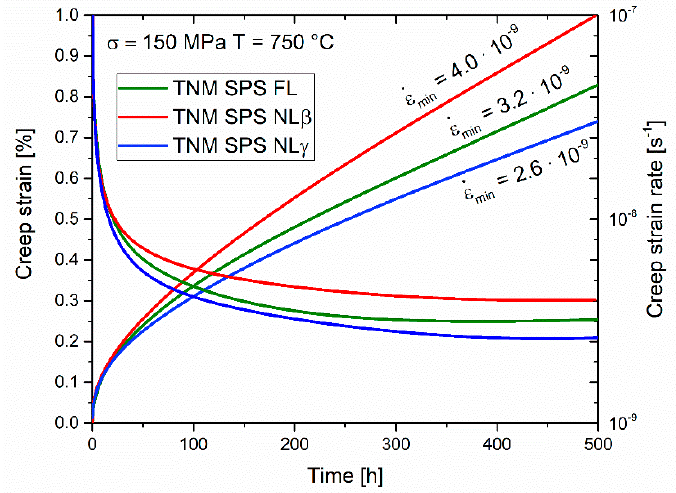
750 ◦ C and 150 Figure 4 . Creep strain and creep strain rate as a function of time of the heat-treated microstructures as a function of time at 750 °C and 150 MPa.